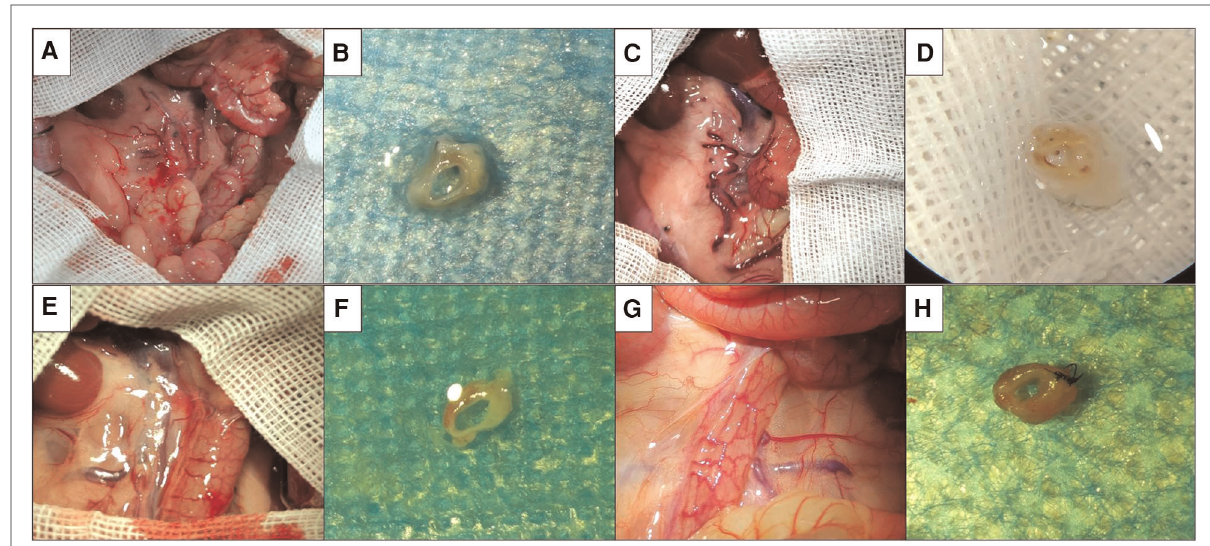
FIGURE 4 Postoperative gross specimens of two models. ( A ) Abdominal exploration at 1 week after operation in the cuff group showed mild adhesion around the vessels at replacement segment, which showed congestion change of surrounding tissues. ( B ) Gross specimen at 1 week after operation in the cuff group showed that the vessels at replacement segment were unobstructed, and no thrombosis was observed. ( C ) Abdominal exploration at 4 weeks after operation in the cuff group showed that there was signi fi cant adhesion around the vessels at replacement segment, which showed formation of a large number of venous collaterals. ( D ) Gross specimen at 4 weeks after operation in the cuff group showed that the vessels at replacement segment were unobstructed, the wall was signi fi cantly thickened, which showed fi brous shell. ( E ) Abdominal exploration at 1 week after operation in the suture group showed that there was no signi fi cant adhesion around the vessels at replacement segment, which showed formation of venous collaterals. ( F ) Gross specimen at 1 week after operation in the suture group showed that the vessels at replacement segment were unobstructed, which showed good shape. ( G ) Abdominal exploration at 4 weeks after operation in the suture group showed mild adhesion around the vessels at replacement segment, which showed formation of local venous collaterals. ( H ) Gross specimen at 4 weeks after operation in the suture group showed that the vessels were unobstructed, which showed slight thickening of